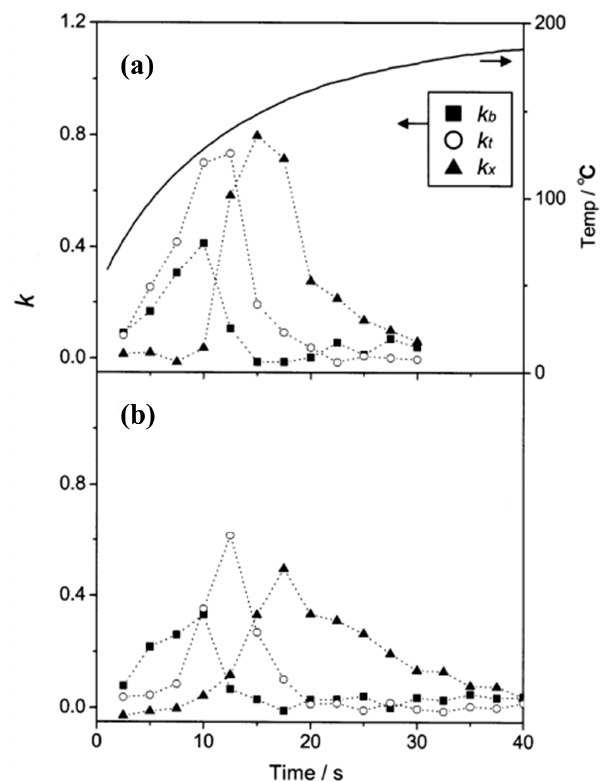
Figure 9. Changes in kb, kt, and kx (coefficients that correspond to the ratio of benzene, toluene, and o -xylene in the mixture gas, respectively) against time when SDP ( a ) and SBA-15 ( b ) are used. The thermal characteristic of the concentration cell with SDP is superimposed on the plot (boldface line). The thermal characteristic of the concentration cell with SBA-15 was not presented as it was very similar to that of SDP. Reproduced with permission from [27]. Copyright 2002, American Chemical Society.